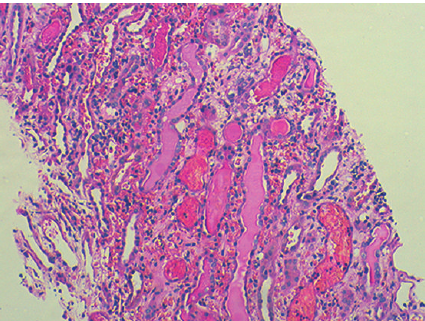
Figure 1: Prominent interstitial hemorrhage and intratubular casts (haematoxylin/eosin staining, magnification 100x).